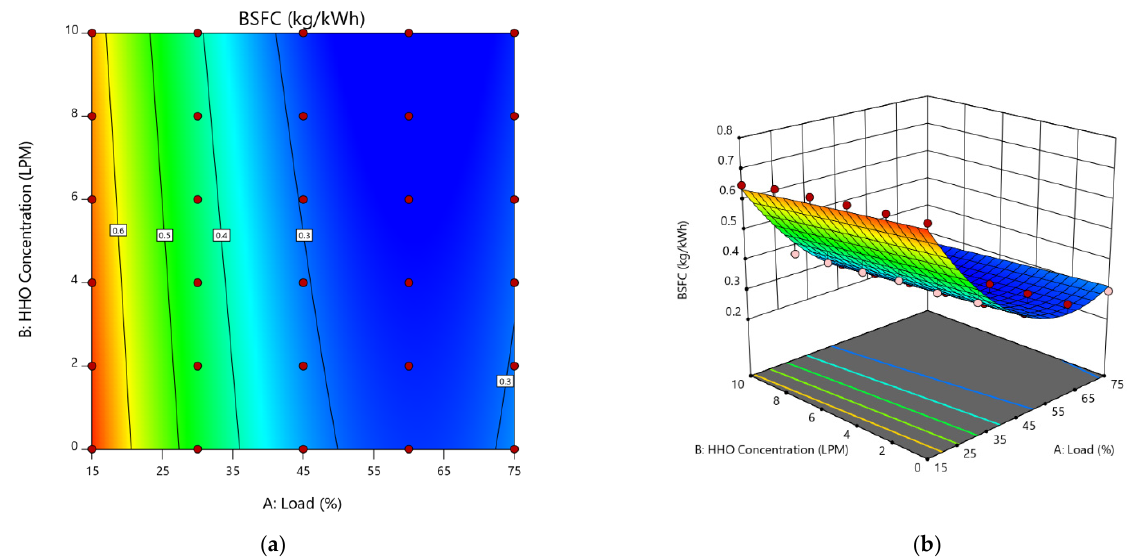
Figure 4. ( a ) Contour plot and ( b ) response surface of BSFC. Similar to performance, quadratic models for emissions were also analyzed using ANOVA. The defined model for CO emissions was significant as shown in Table 7. The results revealed that both factors were significant; however, the percentage contribution of load to overall variations was greater compared to fuel concentration. Moreover, the R 2 value was 0.9819 (refer to Table 8) and there was a reasonable agreement between adjusted and predicted R 2 . In an attempt to see the accuracy of the selected model, the actual versus predicted description in Figure 6 could be used as a model accuracy measuring tool. It is discernible from the figure that the data points are near to the linear regression line and deviations are negligible. The CO emission regression equation on a coded scale is given by Equation